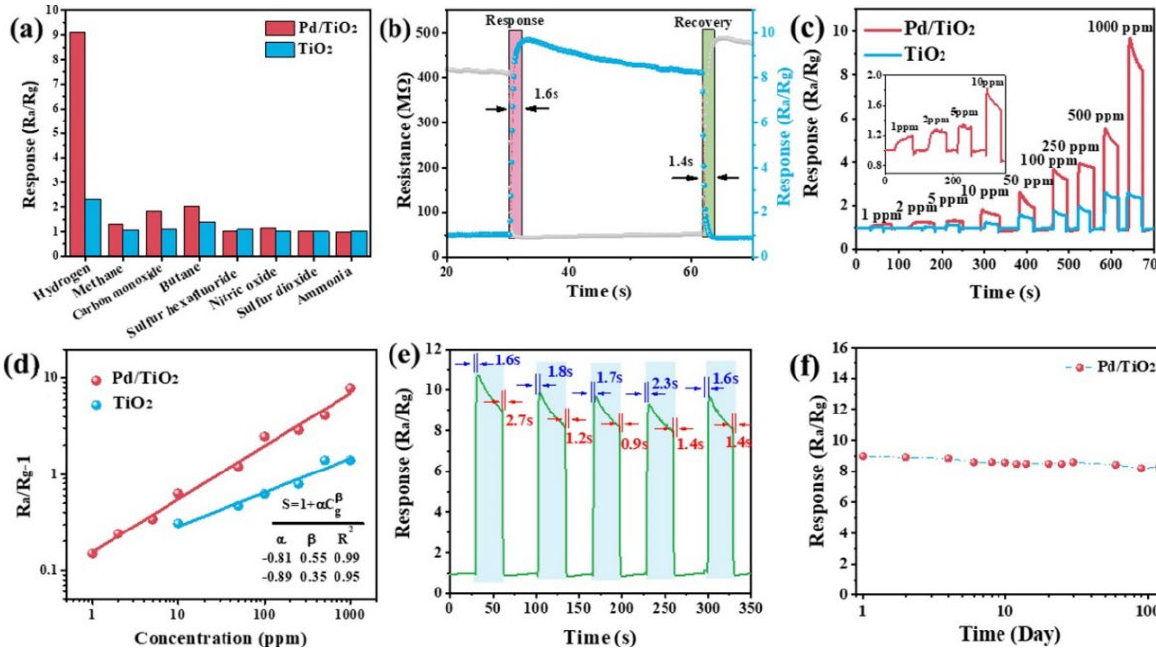
Figure 28. ( a ) Selectivity of TiO 2 NS and Pd/TiO 2 NS sensors toward different references gases (1000 ppm) when operating at 230 °C ; ( b ) response/recovery curve of the sensor based on Pd/TiO 2 NS toward 1000 ppm H 2 when operating at 230 °C ; ( c ) dynamic test curves of the sensors based on TiO 2 NS and Pd/TiO 2 NS when exposed to H 2 with increasing concentration from 1 ppm to 1000 ppm and operating at 230 °C ; ( d ) relationships between R a /R g -1 and H 2 concentration of Pd/TiO 2 NS sensors when operating at 230 °C ; and ( e ) reproducibility and ( f ) long-term stability of the sensor based on Pd/TiO 2 NS toward 1000 ppm H 2 when operating at 230 °C. Reprinted from [148].